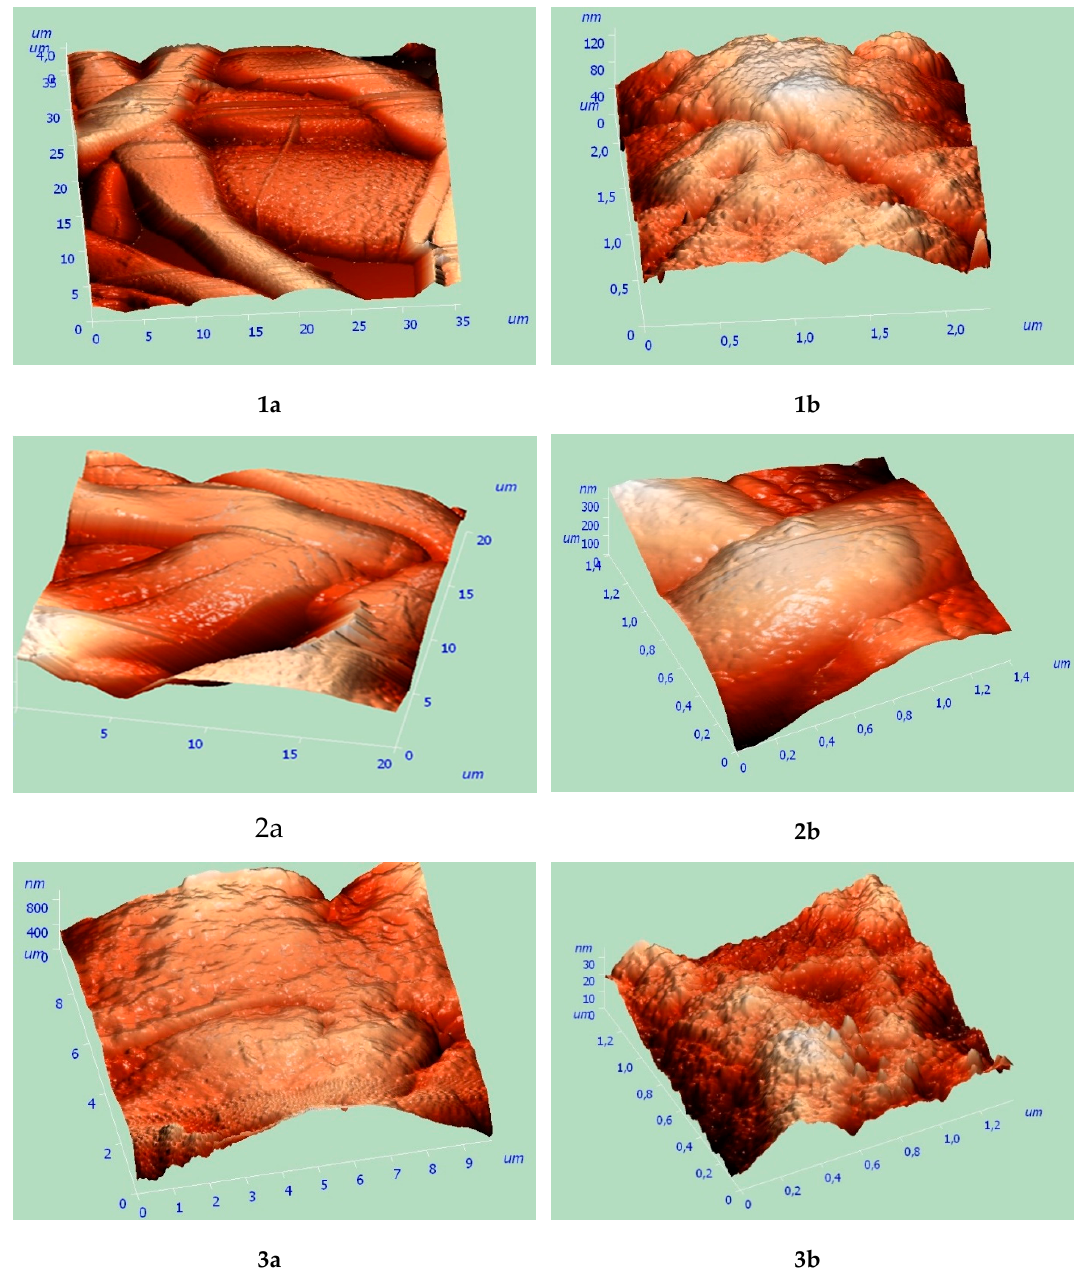
Figure 6. 3D Atomic Force Microscopy AMF images of fibers surfaces for PLA (1), (2) PLA − PHB (50: 50 wt %), and (3) PHB fibers at different magnification ( a , b ).